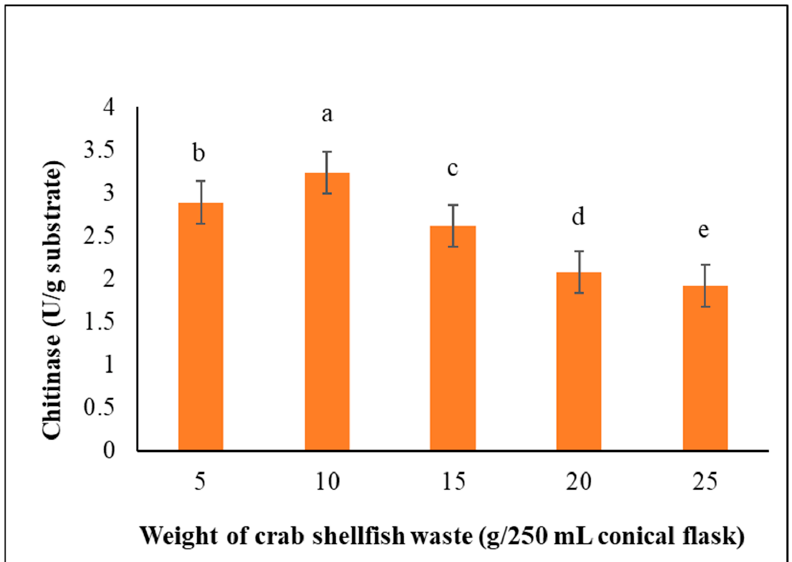
Figure 2. Effect of crab shellfish chitin and on the production of chitinase on SSF by T. funiculosus strain CBS 129594. The values are the means of three replicates with standard deviation (±SD). Mean values in each bar followed by a different lower-case letter are significantly different according to Duncan’s multiple range tests at p ≤ 0.05.